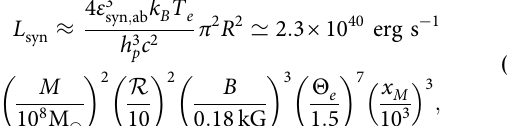
Table 2. RIAFs are optically thick to synchrotron self-absorption at the synchrotron characteristic energy, ε mentary charge. The absorption energy above which RIAFs become optically thin is determined by equating the synchrotron emissivity to the blackbody radiation: ε x M = ε syn,ab / ε syn,ch ~ 10 3 represents the correction from ε syn,ch to ε 30 for the values and the method to estimate x syn,ab . See Ref. The synchrotron luminosity from an optically thick source is given by